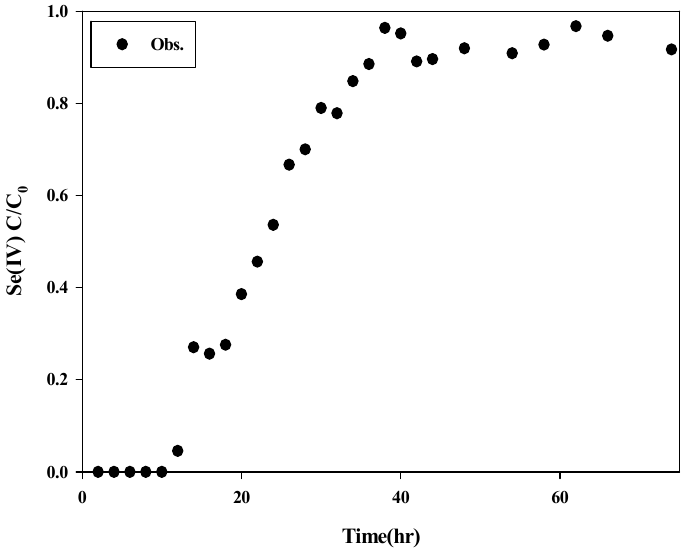
Figure 7. Breakthrough curve of Se(IV) in the LFCM filtration system.